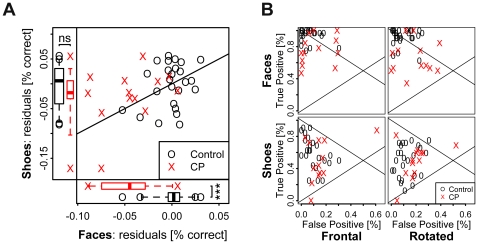
Face recognition memory for faces and shoes.(A) Compared to controls (O), CPs (X) showed worse recognition performance after one year for target faces but not for shoes. (B) The difference in face recognition is largely due to a decreased false positive rate among CPs who failed to detect the target faces more often than controls.